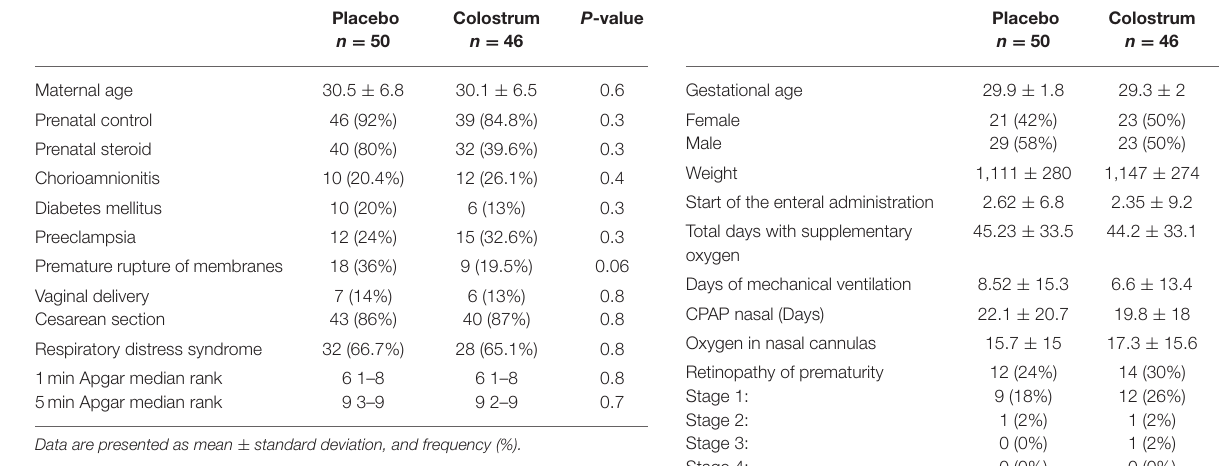
TABLE 1 | Description of the population who completed the treatment. TABLE 2 | Description of the population that completed the follow-up.